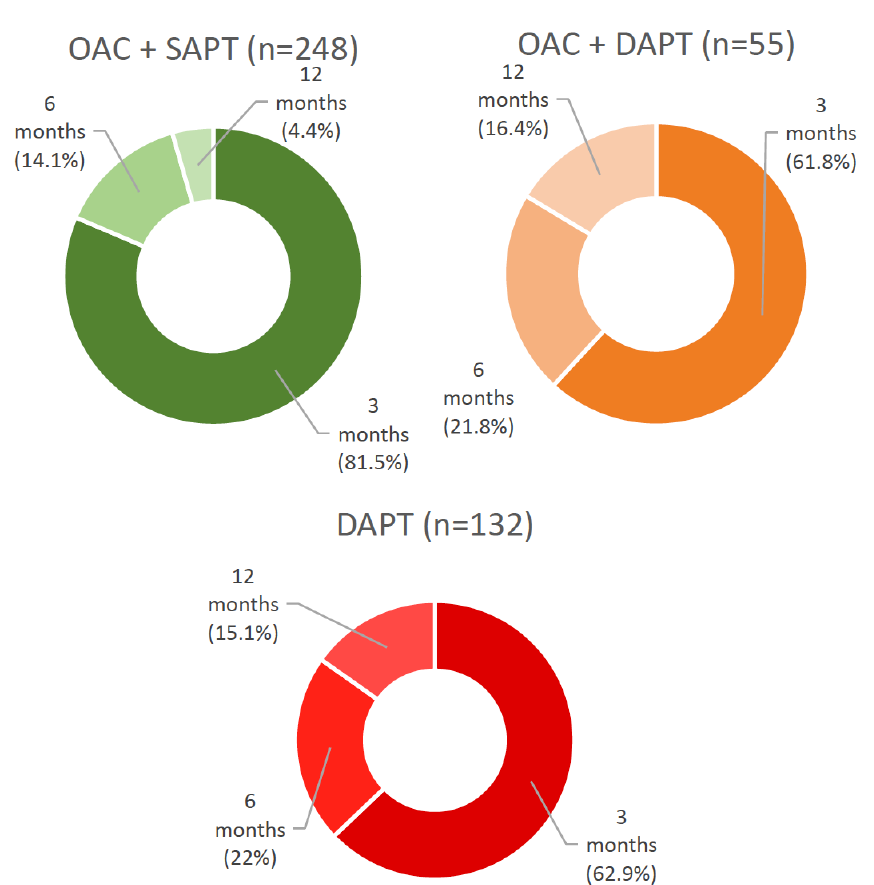
Figure 2. Prescription duration of additional antiplatelet therapy after successful TEER. OAC + SAPT — oral anticoagulant + single antiplatelet therapy, OAC + DAPT — oral anticoagulant + dual antiplatelet therapy, DAPT — dual antiplatelet therapy.